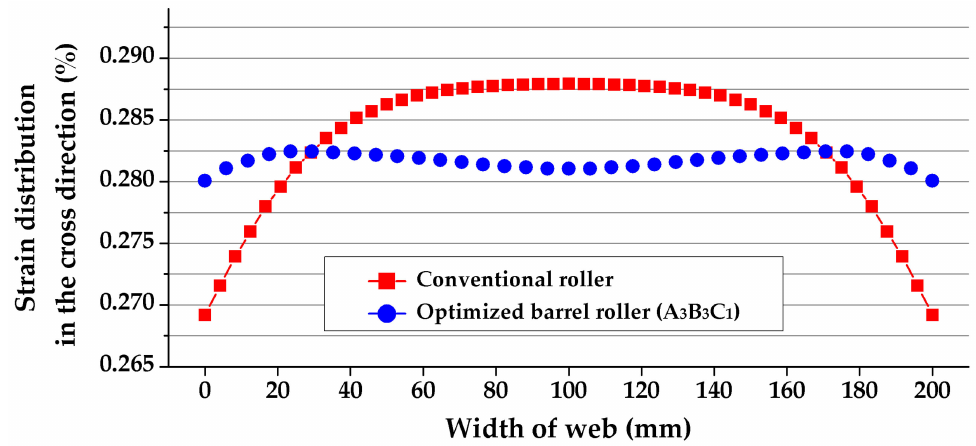
Figure 11. Comparison of strain distribution in the cross direction: Conventional versus optimized barrel roller.